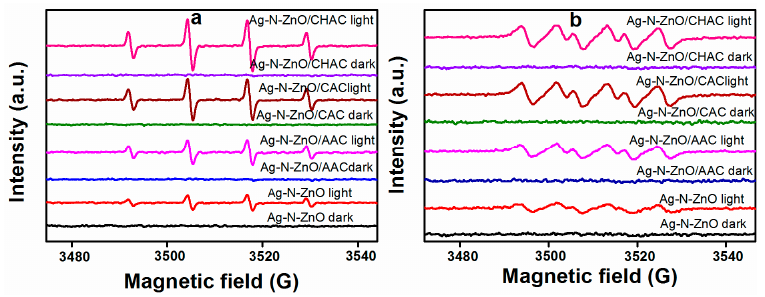
Figure 8. ESR spectra of radical adducts trapped by DMPO over the different photocatalyst dispersions under visible light irradiation; ( a ) DMPO- · OH formed in irradiated aqueous dispersions; ( b ) DMPO-O 2 • − formed in irradiated methanol dispersions.